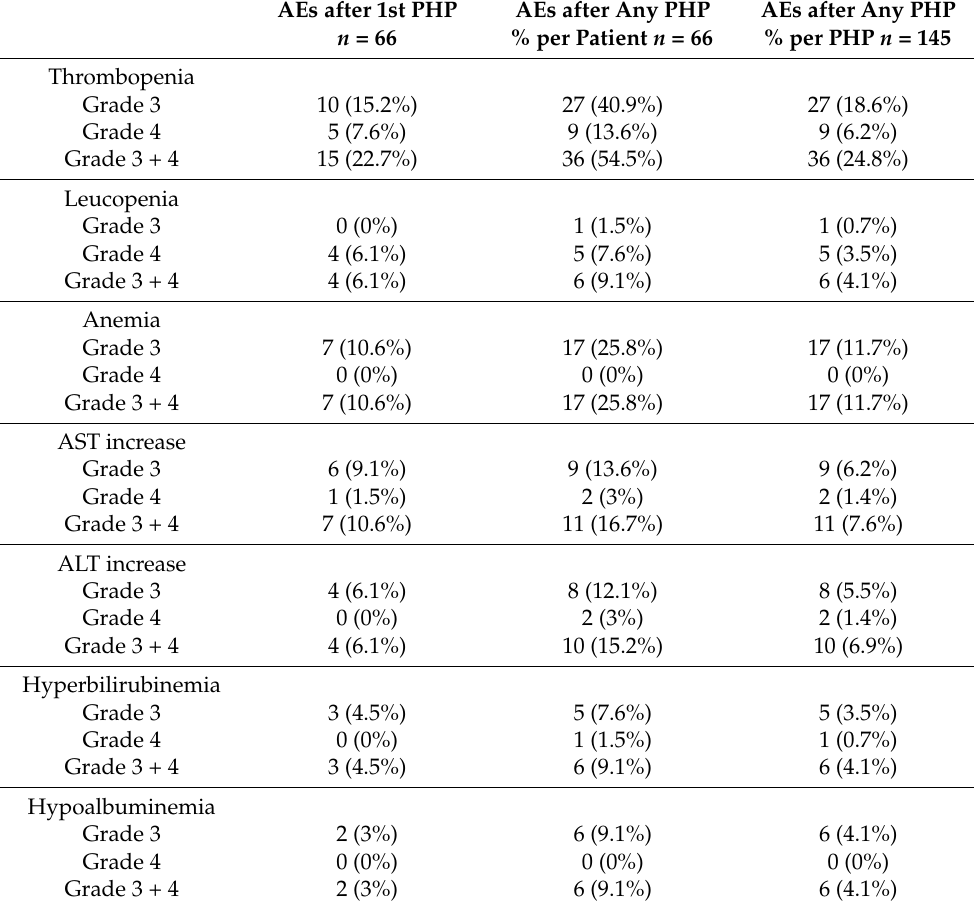
Table 3. Hematologic, hepatic, and biliary adverse events (AEs) grade 3 and 4 (as by CTCAE v.5). Reported are the numbers/percentages of AEs after the first percutaneous hepatic perfusion (PHP) procedure and after any/all PHP calculated per procedure and also per